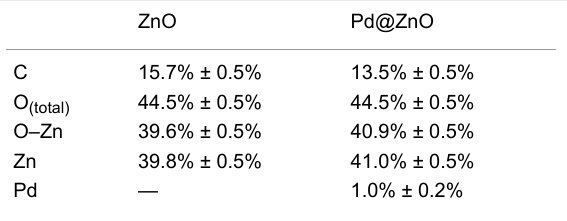
Table 1: XPS surface chemical composition of pristine and Pd-functio- nalized ZnO NRs, annealed at 550 °C. The value for O–Zn refers to the atomic percentage of oxygen bound to